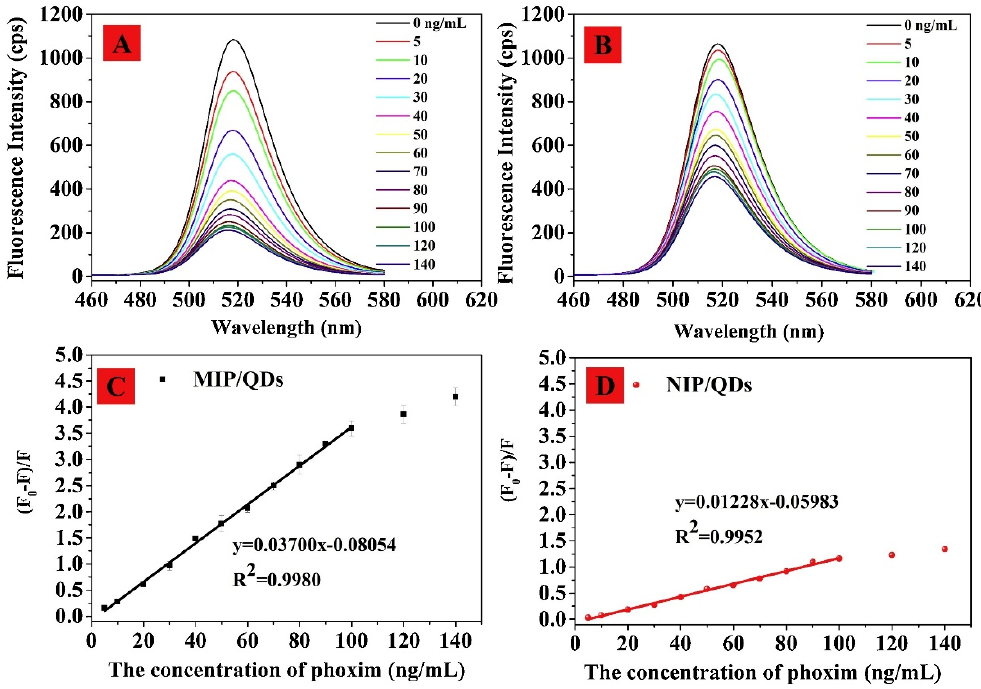
Figure 20. ( A , B ) Effect of phoxim concentration (0–140 ng/mL) on the fluorescence spectra of molecularly imprinted polymer MIP/QDs and NIP/QDs (25 °C). ( C , D ) Stern–Volmer plots of MIP/QDs and NIP/QDs with phoxim (reproduced with the permission from reference [196]). In this light, CsPbBr 1.5 I 1.5 PQD immobilized TiO 2 inverse opal photonic crystals (IOPCs) have